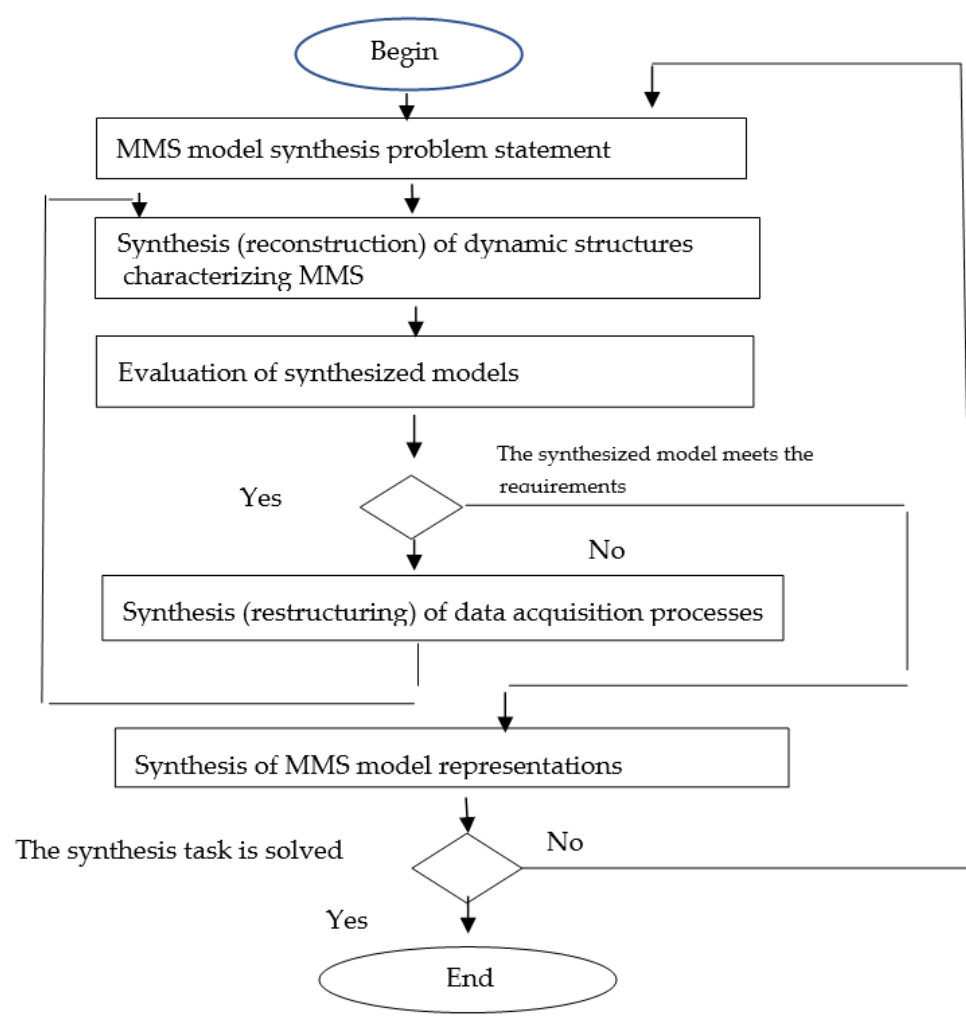
Figure 3. Generalized algorithm of multilevel synthesis of MMS models.